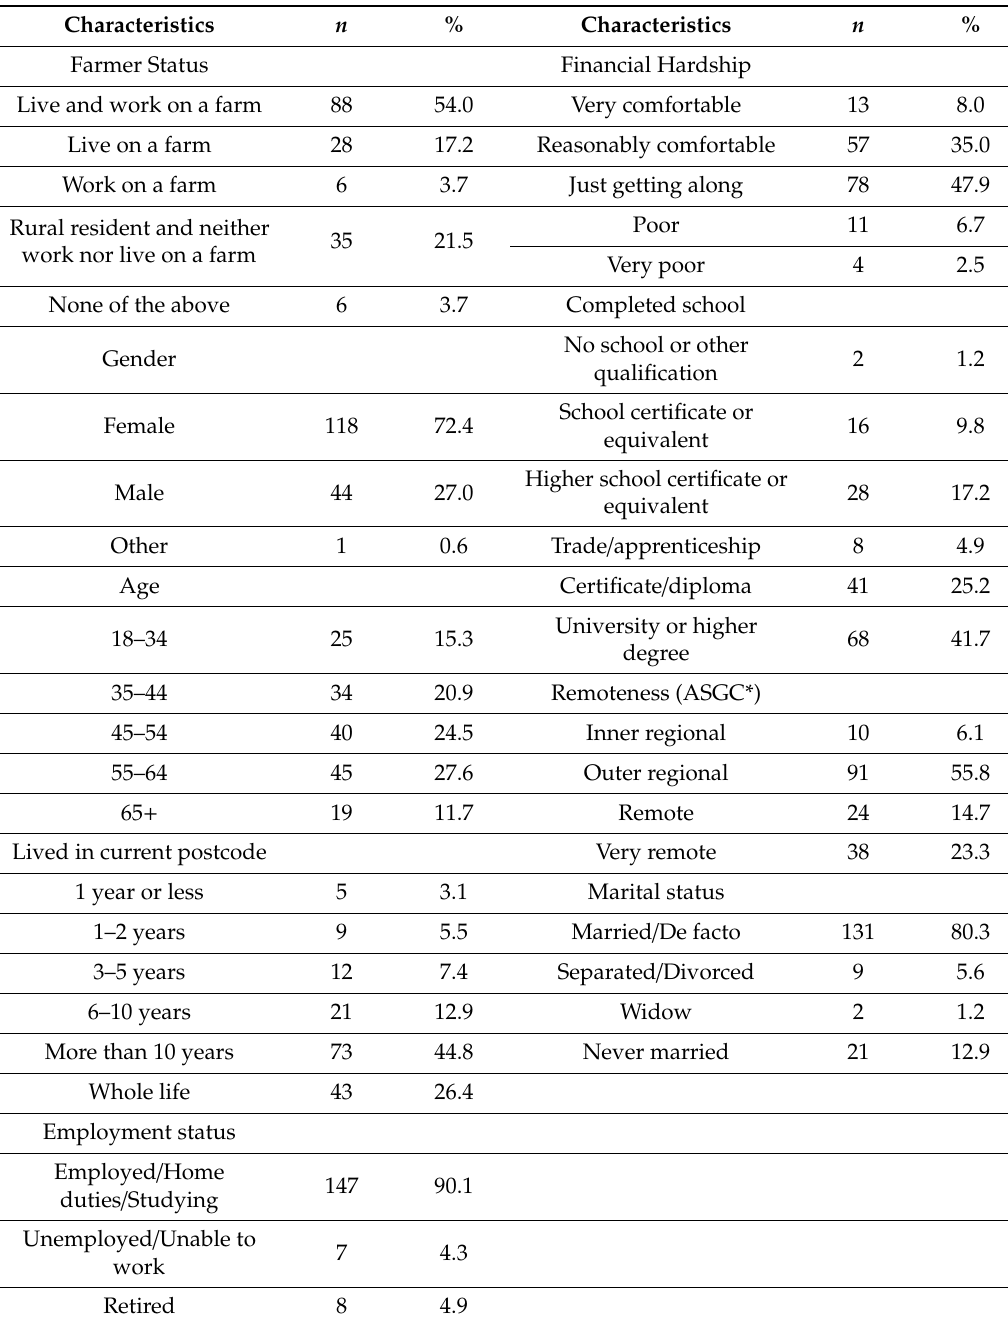
Table 2. Sociodemographic characteristics of the study